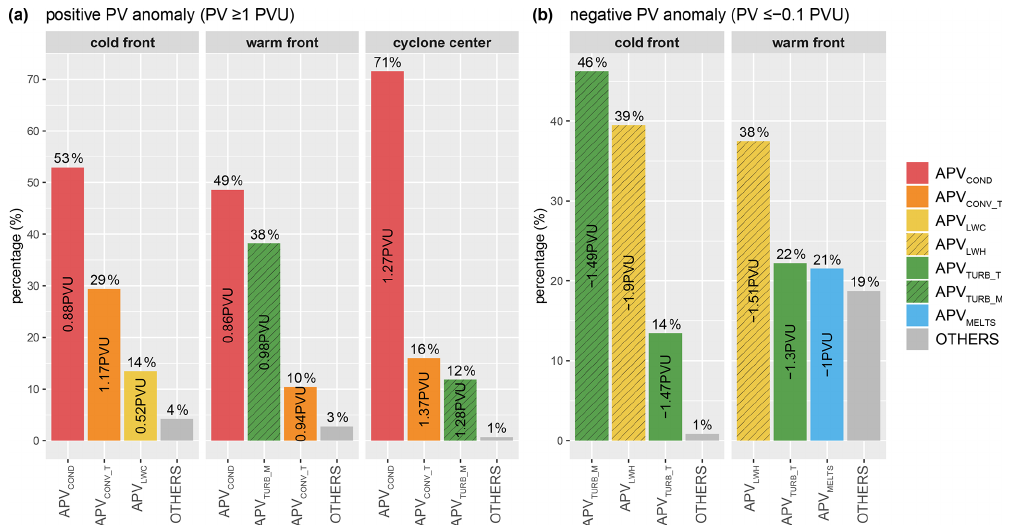
Figure 4. Prevalence of the most important processes for the generation of (a) the positive PV anomaly (PV ≥ 1PVU) between the surface and 550hPa and (b) the negative PV anomaly (PV ≤− 0 . 1PVU) between the surface and 850hPa during the cold season. Ranks are computed from the area-weighted mean APV of each process averaged over the entire 24h period of most rapid cyclone intensification. Percentages indicate the fraction of cyclones with a specific process as the most important one. Numbers show the area-weighted mean APV averaged over all cyclones from the respective